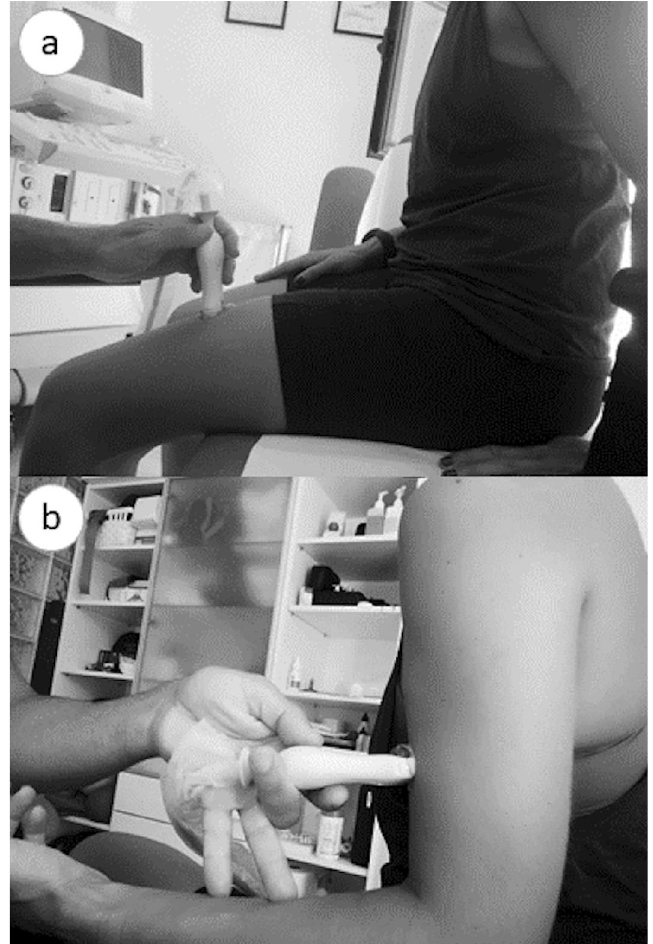
Figure 1. Position of the patient and the ultrasound device for ultrasound assessment of the quadriceps ( a ) and the biceps brachii and brachialis ( b ).